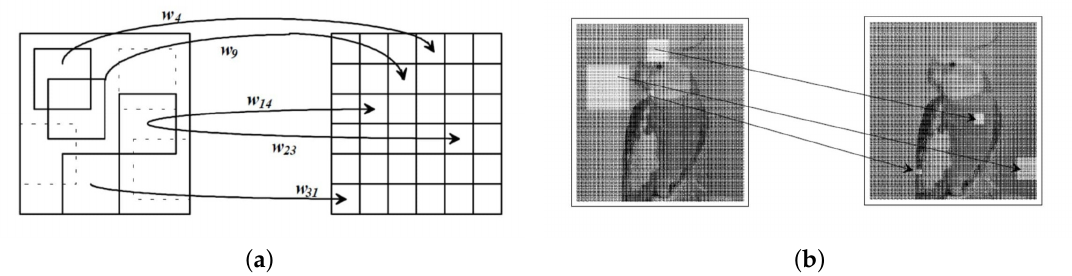
Figure 31. Self-similarity in Partitioned Iterated Function System, ( a ) Domain (left) and Range (right) blocks, ( b ) Domain–range pair self-similarity at three scales. Reprinted with permission from [47]. Copyright 1997